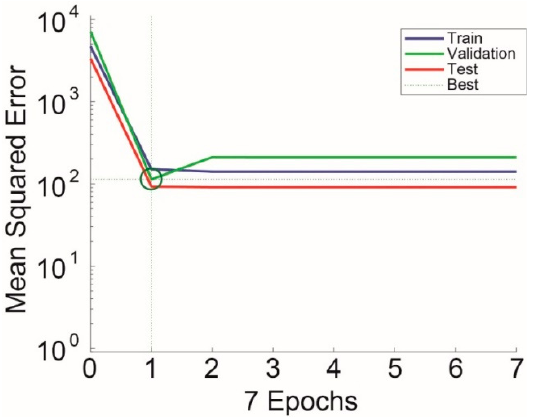
Figure 9. Performance curve for predicting NO x conversion percentage, X.